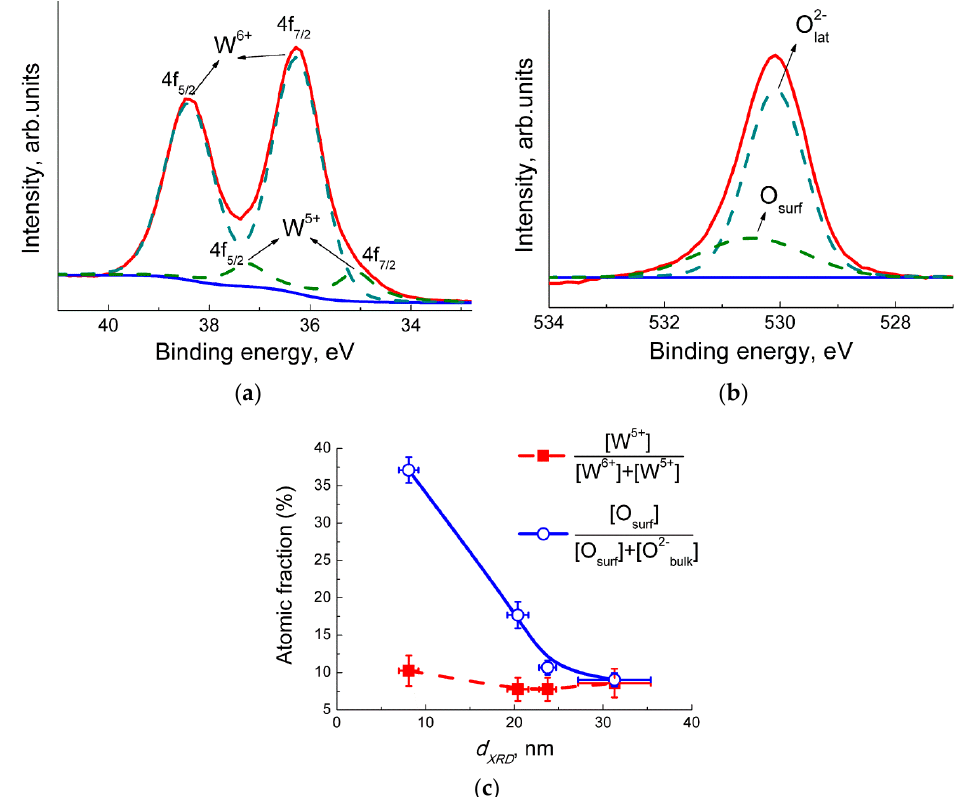
Figure 4. XPS spectra of WO 3 with grain sizes 7–9 nm in the analytic regions: ( a ) W 4f; ( b ) O 1s. ( c ) Fractions of W 5+ from total W content and of surface oxygen in total O content in relation to WO 3 grain size.